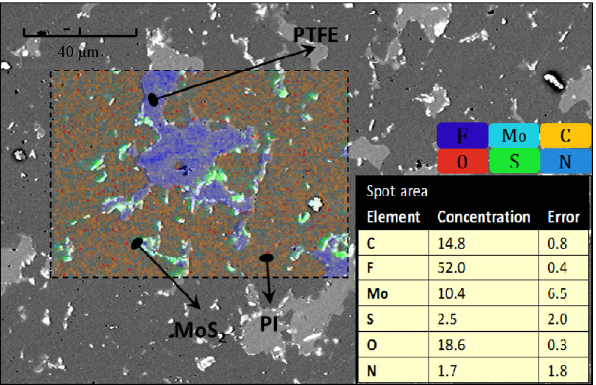
Fig. 2 Typical EDS spectra of PI disk at different